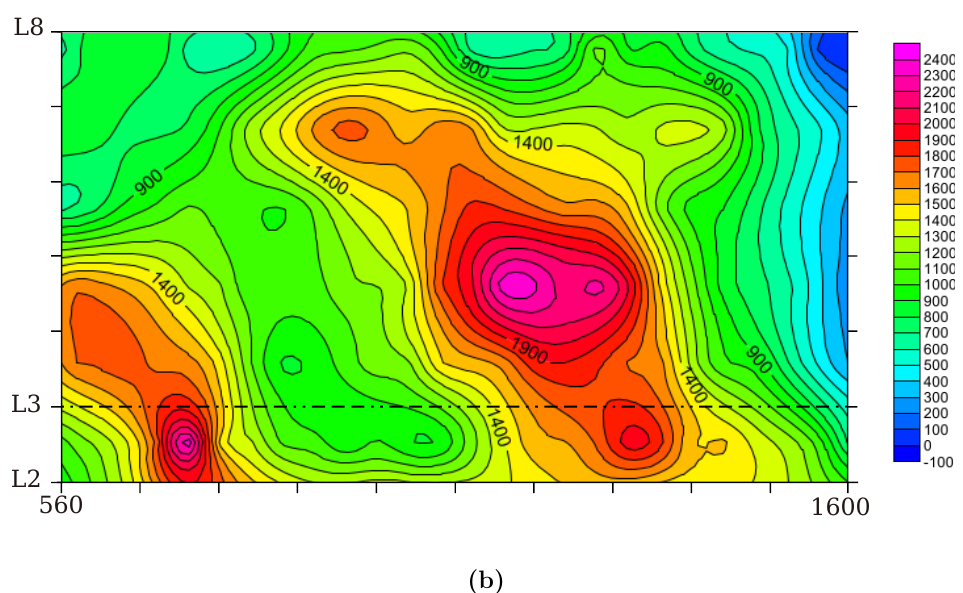
Figure 10. Gravity modeling of subarea A2. (a) Variation of the density, in g/cm 3 , of 208 prismatic bodies with tops 5m deep, bases 105m deep and horizontal sides 40m E-W × 100m S-N. (b) Respective modelled residual gravity in µ